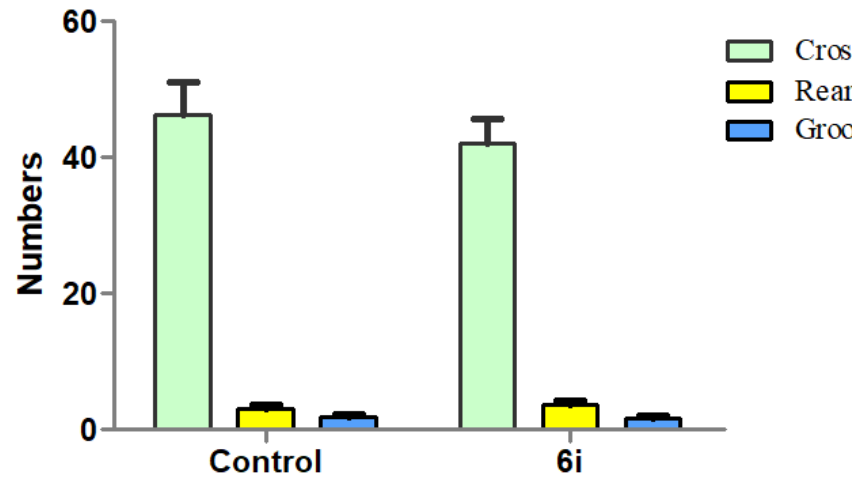
Figure 4. Exploratory activity (counts) in the OFT. The behavioral parameters were recorded for 3 min. Locomotion: number of line crossings; rearing: number of times seen standing on hind legs; grooming: number of modifications; 6i (40 mg/kg) was administered 60 min before the test. The values represent the mean ± SEM ( n = 8).